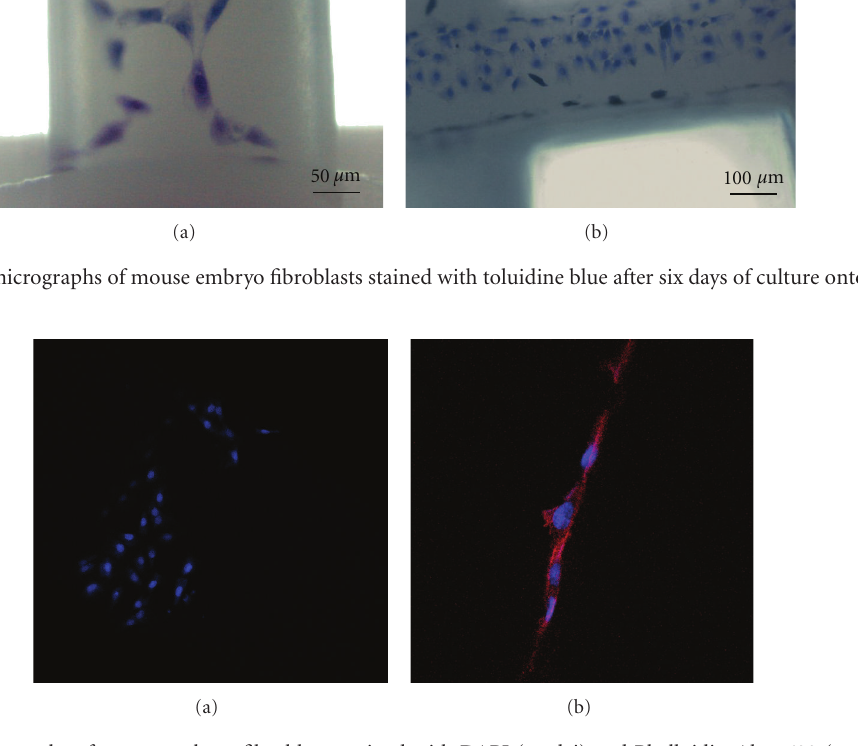
Figure 9: Confocal micrographs of mouse embryo fibroblasts stained with DAPI (nuclei) and Phalloidin-Alexa633 (cytoskeleton) after 6 days of